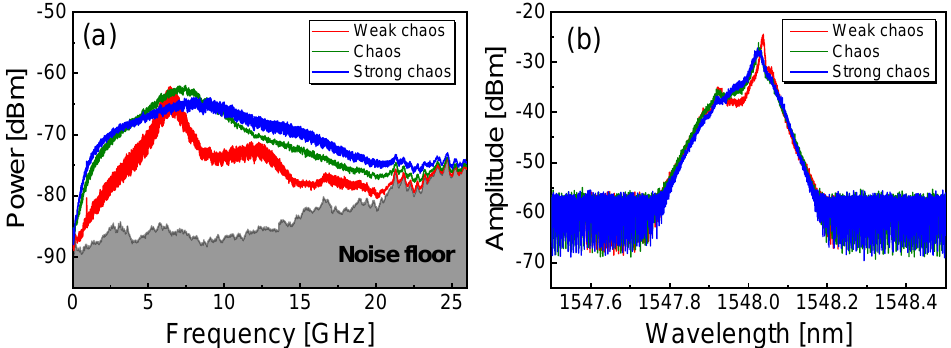
Figure 2. ( a ) Measured frequency spectrum and ( b ) optical spectrum of the chaotic laser, when J = 1.5Jth and η = 2.66% (weak chaos), 8.87% (chaos), 30.31% (strong chaos).